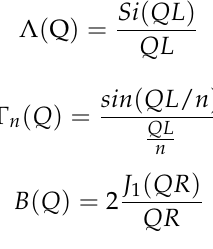
diluting the samples following SANS experiments. Figure S3: Curves obtained by ab initio analyses (red lines) and data points used for each condition (squares: pD 6.4, circles: pD 9.6, triangles: pD ~13). Figure S4: The estimation of I(0) values by extrapolation of the I( Q ) SANS curves (top panels) and Guinier plots (bottom panels) at pD 1.7 (A, red), 6.4 (B, orange), 9.6 (C, green), and ~13 (D, blue). The black solid lines in the top panels are fitted I( Q ) SANS curves by Fourier transformation of P ( r ) at each pD value, and the black dashed lines in the bottom panels were obtained from linear Guinier fitting. The I(0) point at each pD value is marked by a diamond on the vertical axis. Figure S5: Fitting of BUNCH simulations (red line) versus the experimental SANS curve at pD ~13 (blue circle). Table S1: Details of sample used in SANS experiment. Table S2: SANS data collection parameters. Table S3: parameters determined from SANS